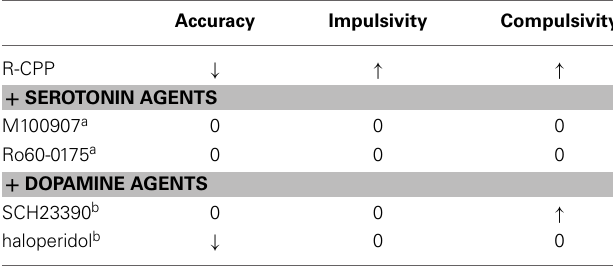
Table 4 | The effects of serotonin and dopamine receptors agents injected in the dm-STR on attention and executive deficits induced by R-CPP injections in the